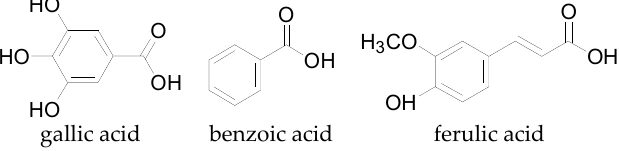
Figure 13. Chemical structures of some phenolic acids present in cotton.